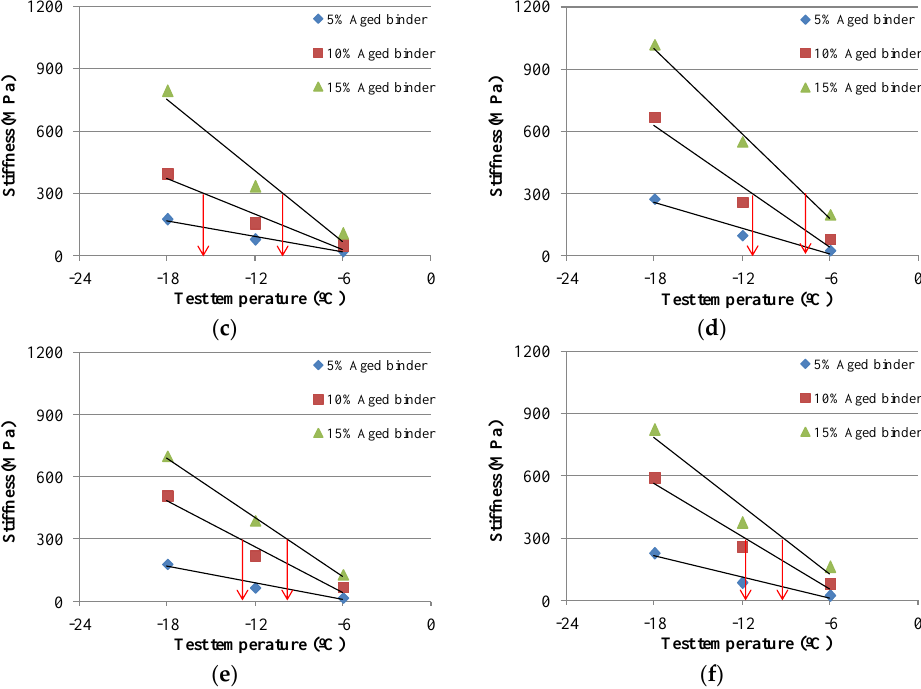
Figure 8. Minimum low temperature determinations of RAP sources A–F with PAV binder PG 58-28 in terms of stiffness, ( a – f ) RAP sources A–F.